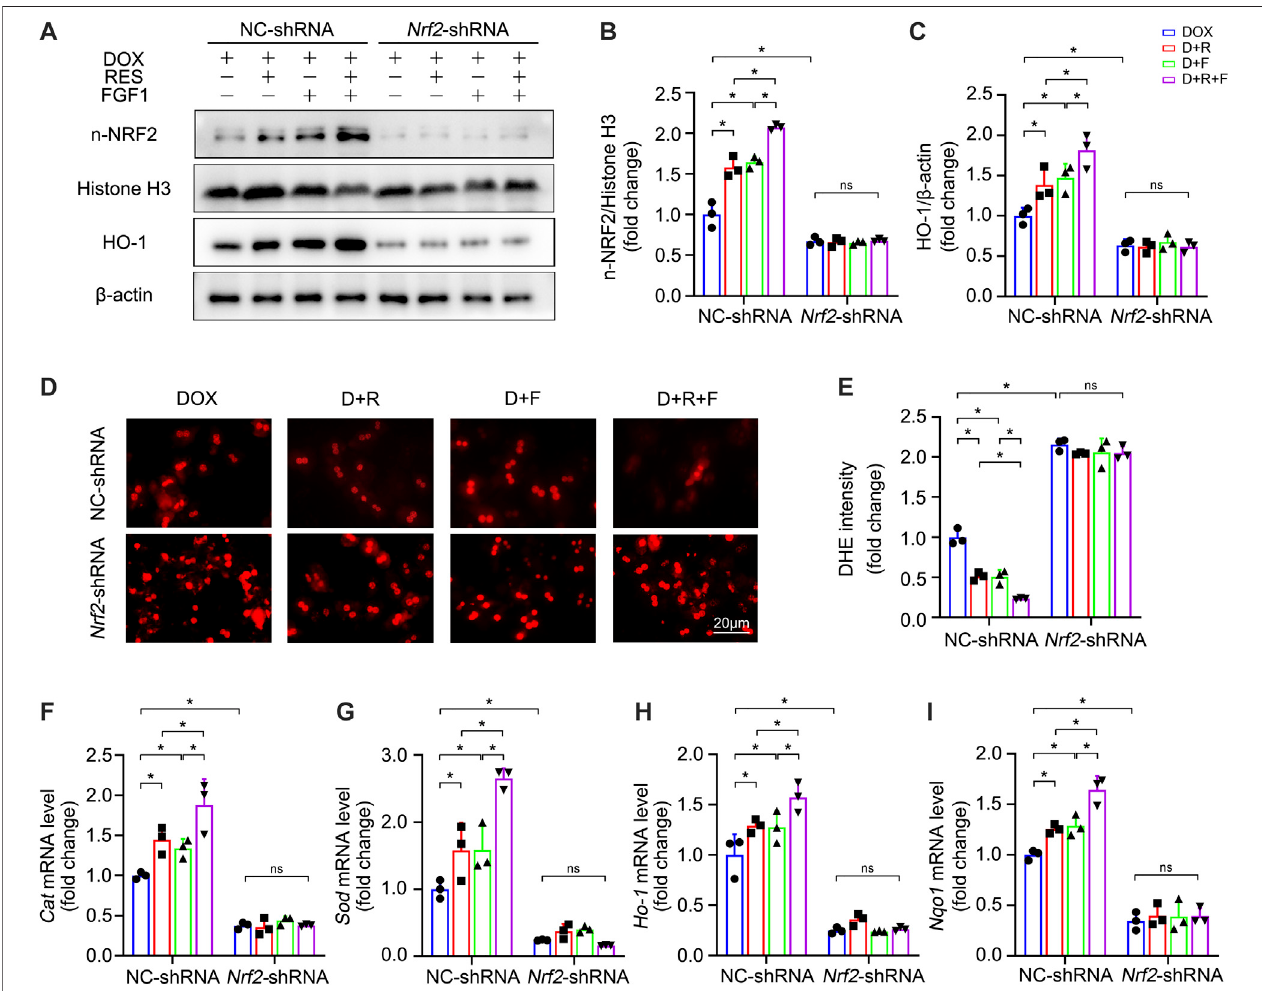
FIGURE 4 | shRNA-mediated Nrf2 knockdown diminished the protective effects of RES and FGF1 co-treatment against DOX-induced oxidative stress in primary hepatocytes. (A-C) Relative protein expression levels of n-NRF2 and HO-1 in primary hepatocytes after the indicated treatments. Three independent experiments were performed. β -actin or histone H3 was used as the loading control. (D,E) Representative fl uorescence microscopy images of DHE-stained primary hepatocytes after the indicatedtreatments( n =3). (F – I) RelativemRNAexpressionlevelsofoxidativestressmarkers Cat , Sod , Ho-1, and Nqo1 inprimaryhepatocytesaftertheindicated treatments ( n = 3). Data are expressed as mean ± SD. * p < 0.05; ns indicates not signi fi